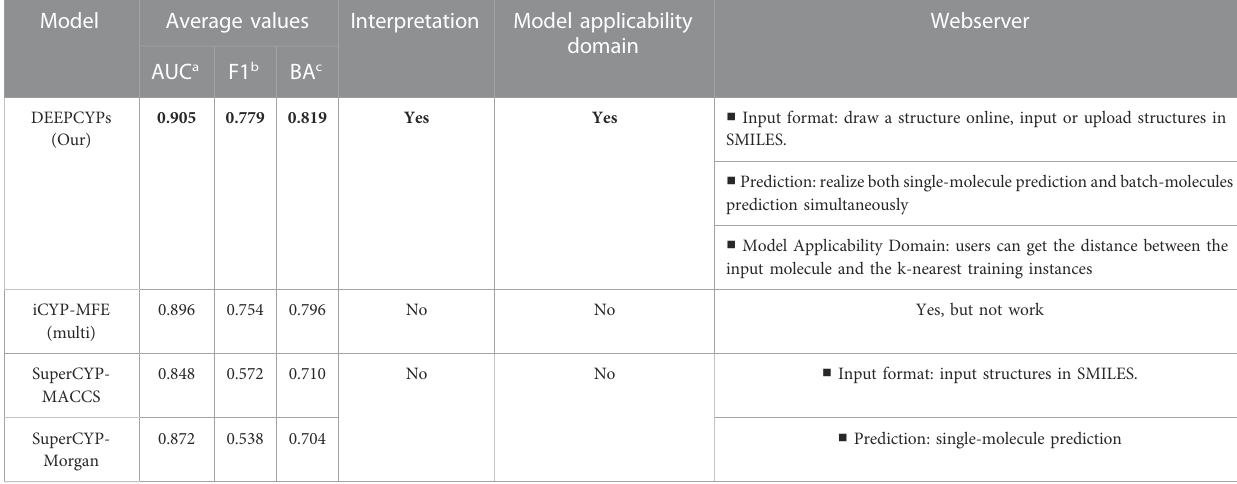
TABLE 3 The detailed comparison of DEEPCYPs and the most advanced existing models (SuperCYP and iCYP-MFE).